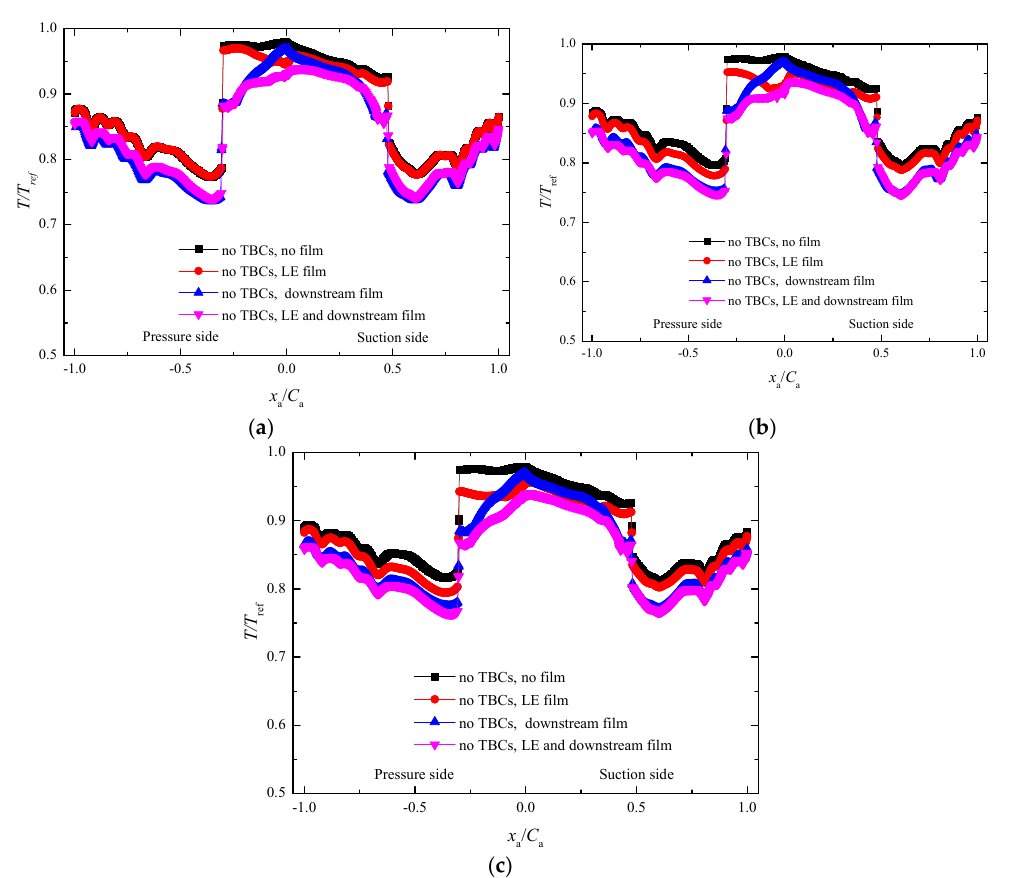
Figure 7. Surface temperature distribution comparisons for different cases. ( a ) z = −19.3 mm, ( b ) z = 0 mm, ( c ) z = 19.3 mm.